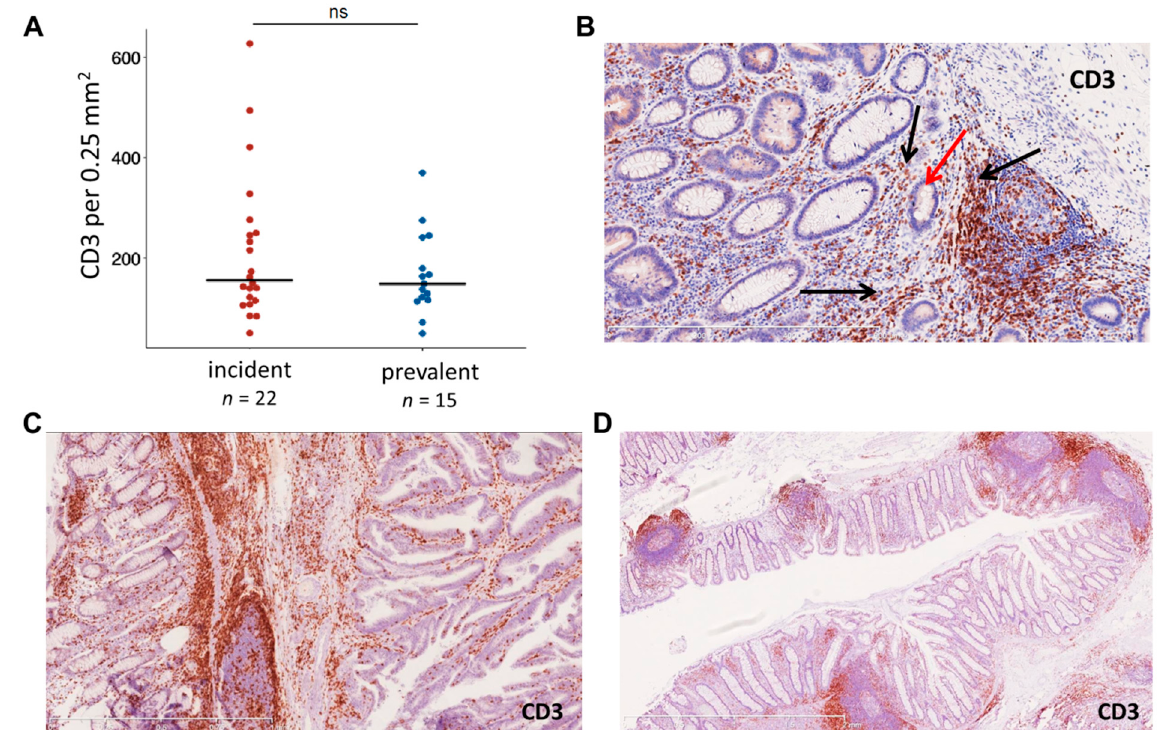
Figure 5. Immune infiltration with CD3-positive T cells in incident and prevalent cancers. ( A ) Immune infiltration in MLH1-associated incident and prevalent LS CRC. ( B – D ) Exemplary CD3 stainings of an MMR-deficient crypt ( B ) (see Figure 2B for the MLH1 staining, red arrow points to the MMR-deficient crypt, black arrows point at the CD3-positive T cell infiltration), tumor ( C ) and normal mucosa ( D ) regions of a transverse colon cancer specimen.